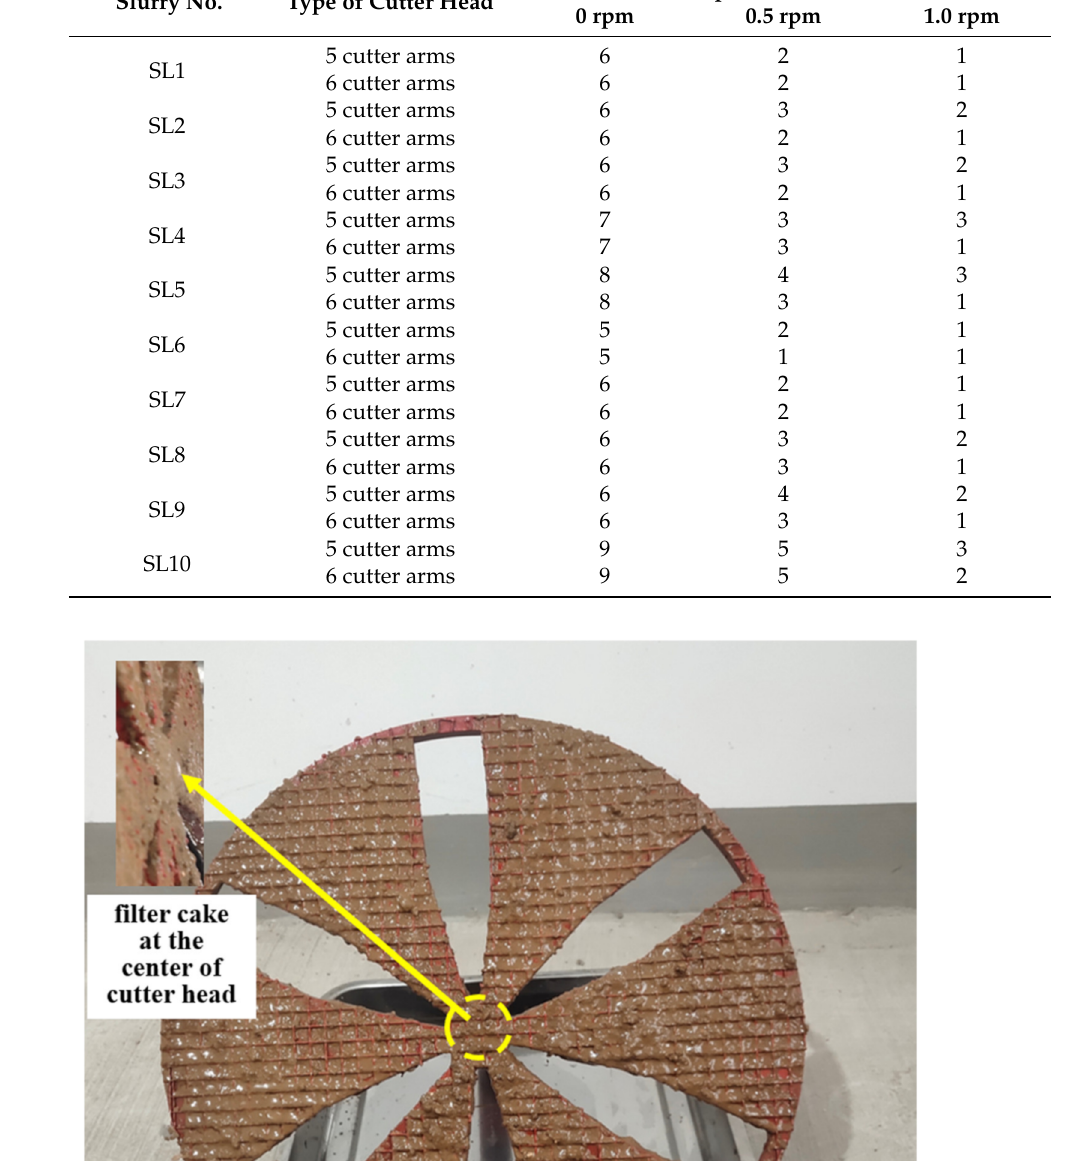
Table 3. Thickness of the Filter Cake (mm). Slurry No.